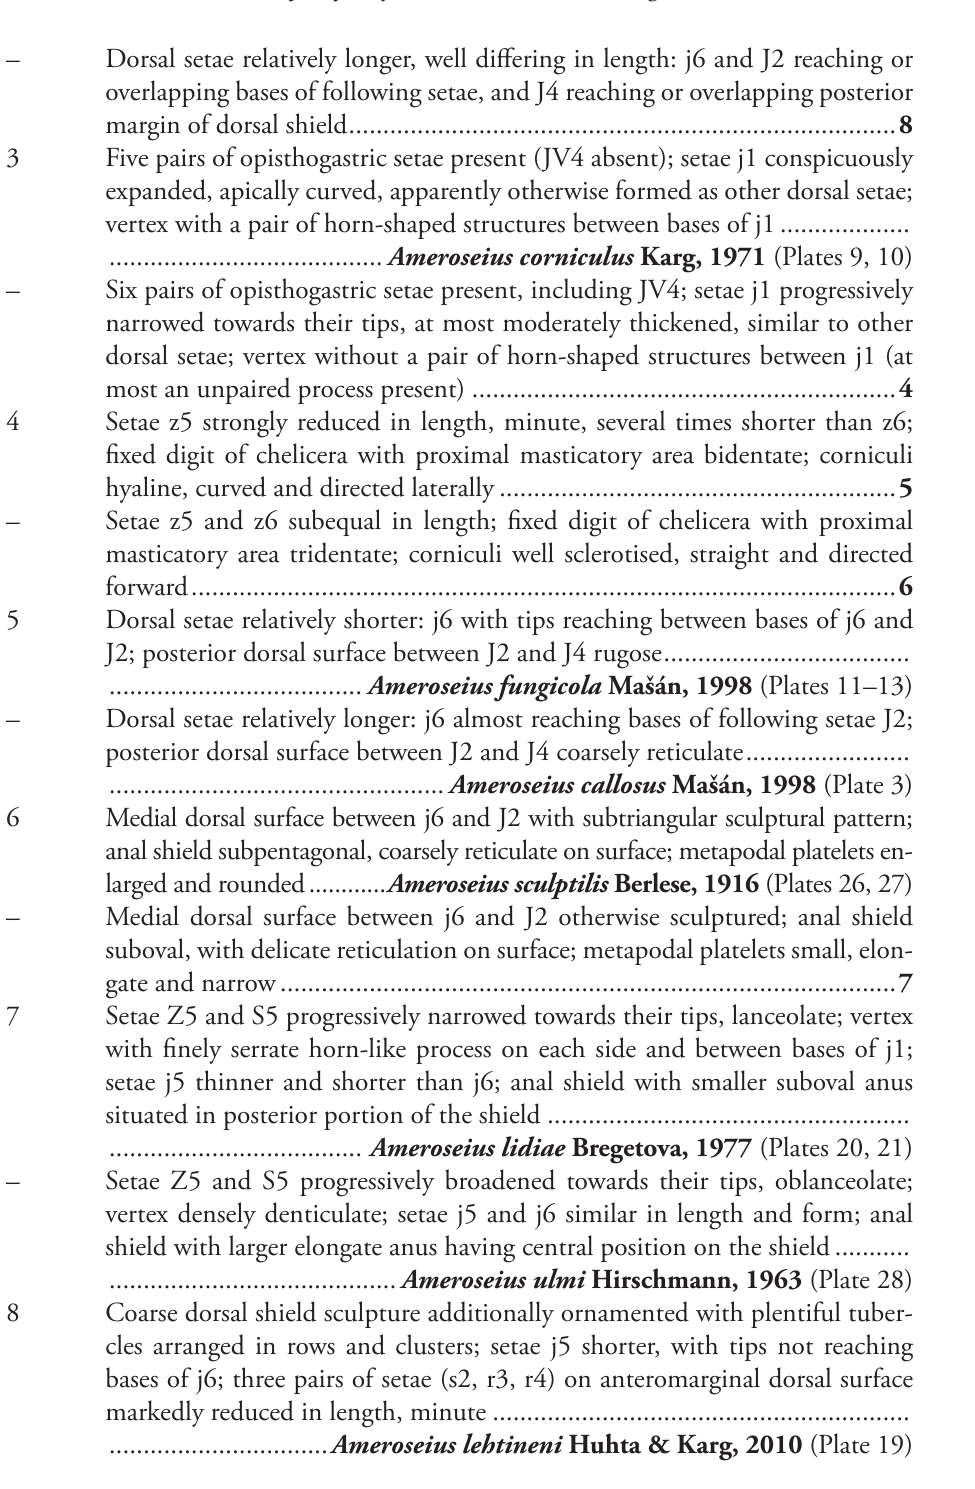
– Dorsal setae relatively longer, well differing in length: j6 and J2 reaching or overlapping bases of following setae, and J4 reaching or overlapping posterior margin of dorsal shield ................................................................................ 8 3 Five pairs of opisthogastric setae present (JV4 absent); setae j1 conspicuously expanded, apically curved, apparently otherwise formed as other dorsal setae; vertex with a pair of horn-shaped structures between bases of j1 ................... – Six pairs of opisthogastric setae present, including JV4; setae j1 progressively narrowed towards their tips, at most moderately thickened, similar to other dorsal setae; vertex without a pair of horn-shaped structures between j1 (at most an unpaired process present) .............................................................. 4 4 Setae z5 strongly reduced in length, minute, several times shorter than z6; fixed digit of chelicera with proximal masticatory area bidentate; corniculi hyaline, curved and directed laterally .......................................................... 5 – Setae z5 and z6 subequal in length; fixed digit of chelicera with proximal masticatory area tridentate; corniculi well sclerotised, straight and directed 5 Dorsal setae relatively shorter: j6 with tips reaching between bases of j6 and J2; posterior dorsal surface between J2 and J4 rugose .................................... – Dorsal setae relatively longer: j6 almost reaching bases of following setae J2; posterior dorsal surface between J2 and J4 coarsely reticulate ........................ 6 Medial dorsal surface between j6 and J2 with subtriangular sculptural pattern; anal shield subpentagonal, coarsely reticulate on surface; metapodal platelets en- larged and rounded ............ Ameroseius sculptilis Berlese, 1916 (Plates 26, 27) – Medial dorsal surface between j6 and J2 otherwise sculptured; anal shield suboval, with delicate reticulation on surface; metapodal platelets small, elon- 7 Setae Z5 and S5 progressively narrowed towards their tips, lanceolate; vertex with finely serrate horn-like process on each side and between bases of j1; setae j5 thinner and shorter than j6; anal shield with smaller suboval anus